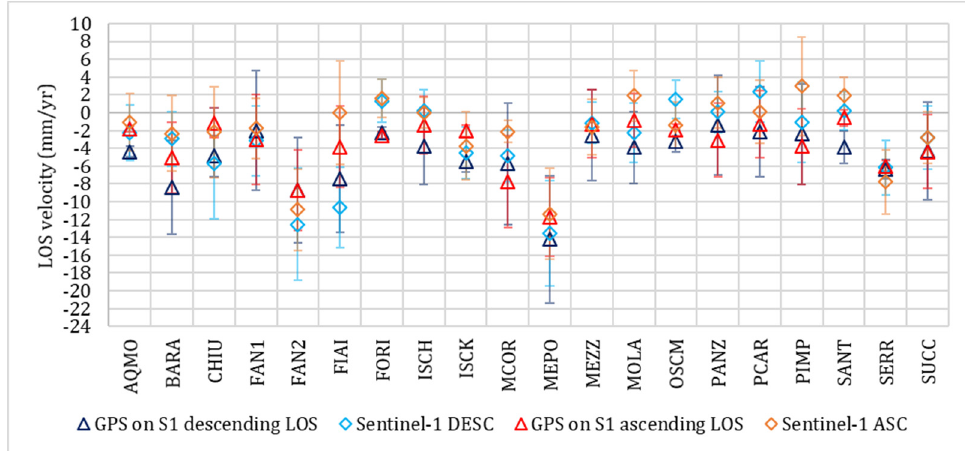
Figure 7. Comparison between GPS displacement rates reprojected on Sentinel-1A descending (blue triangles) and ascending (red triangles) LOS and, respectively, displacement rates evaluated through SBAS processing: descending track (light blue diamonds) and ascending track (orange diamonds).